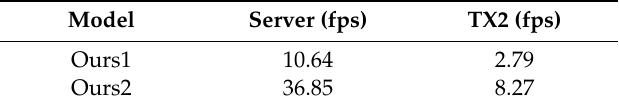
Table 5. The fps of Ours1 and Ours2.